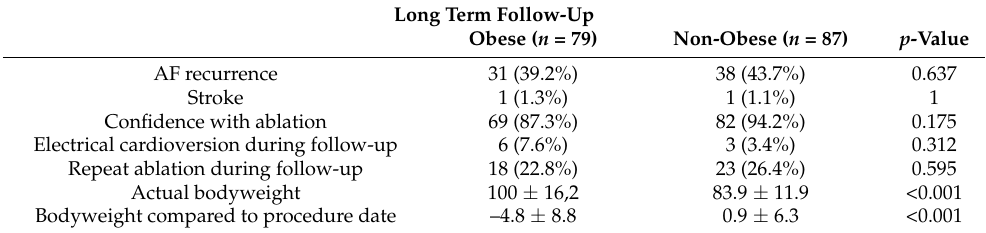
Table 4. Long-term follow-up of obese and non-obese patients following PVI.